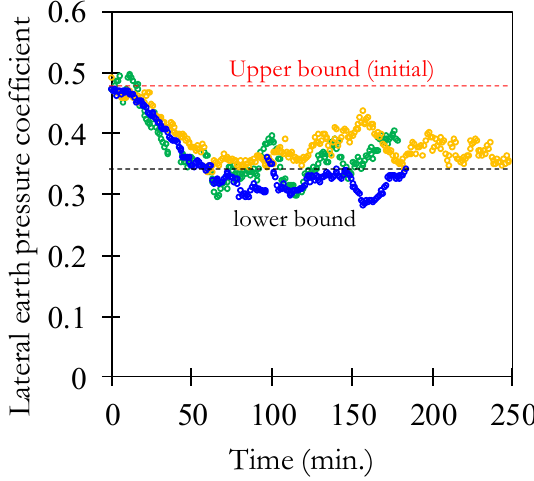
Fig. 3 . EPC variation with time for pH 2.8 (different data series correspond to independent repetitions).